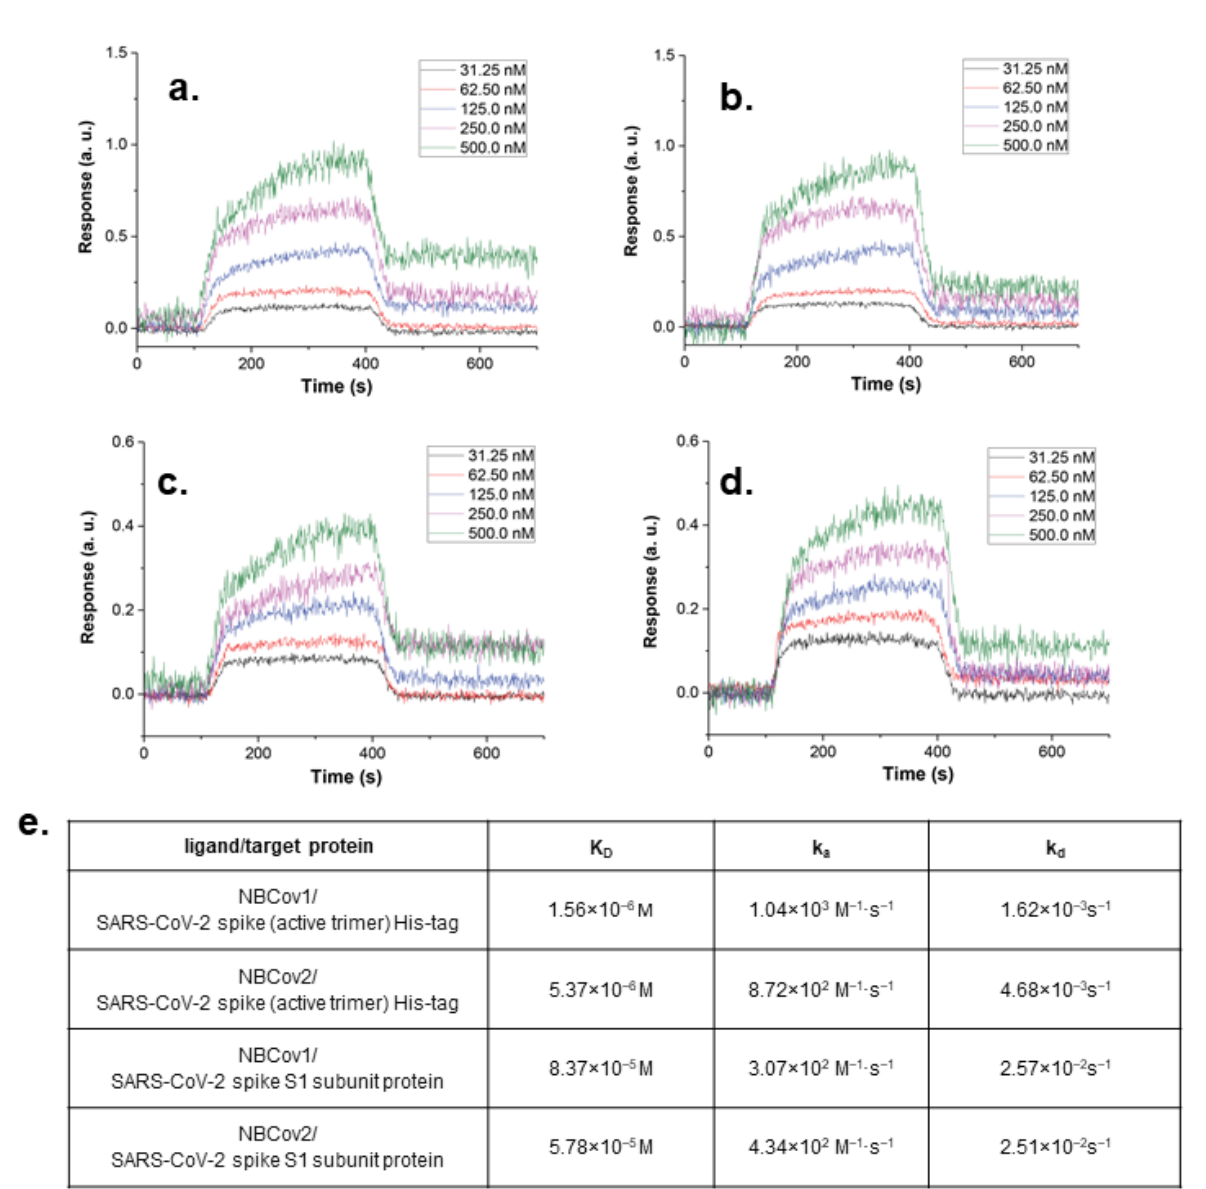
Figure 3. Evaluation of binding affinity of NBCoV1 and NBCoV2 to SARS-CoV-2 active trimer and SARS-CoV-2 S1 subdomain by SPR. Kinetics fitting curve (sensogram) of SARS-CoV-2 trimer to ( a ) NBCoV1; ( b ) NBCoV2. Kinetics fitting curve (sensogram) of SARS-CoV-2 S1 subdomain to ( c ) NBCoV1 and ( d ) NBCoV2. The binding affinity K D and kinetic parameters k on and k off of ( e ) NBCoV1 and NBCoV2.